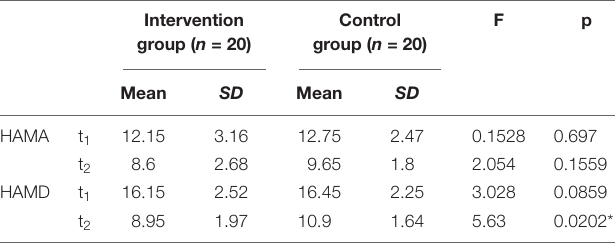
TABLE 3 | HAMA and HAMD questionnaire